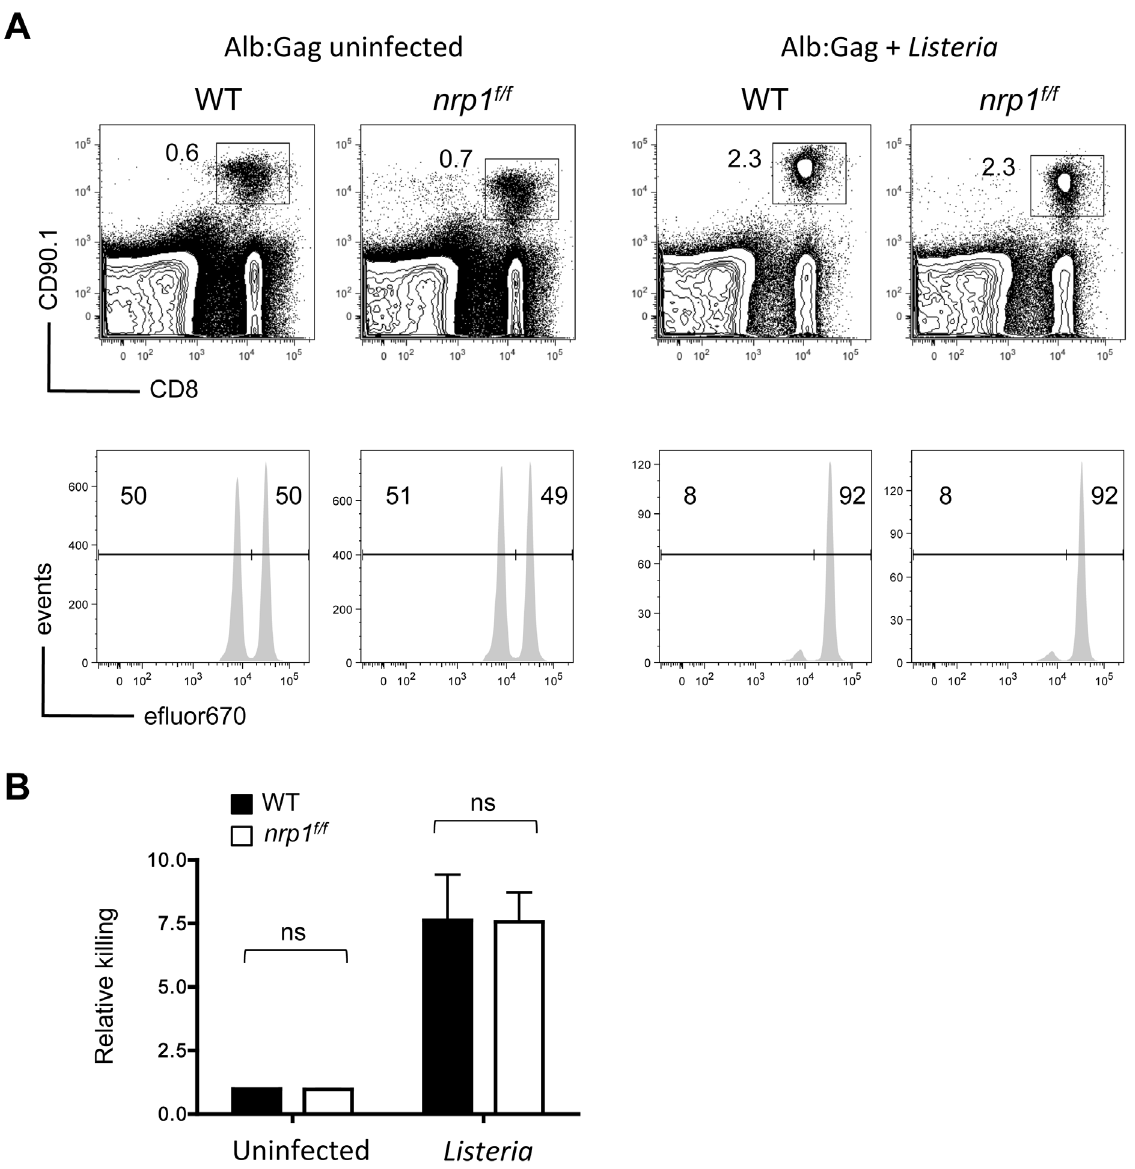
Figure 4. The cytotoxic potential of tolerant CD8 + T cells is not regulated by Nrp1. WT or Nrp1-deficient CD90.1 + Gag-specific CD8 + T cells were transferred into Alb:Gag recipients with or without Listeria infection. Three days after transfer, recipients were infused with a 1:1 ratio of Gag (eFluor 670 low ) and control (eFluor 670 high ) peptide-pulsed target cells. Twenty hours later (day 4), recipient spleens were harvested and the frequency of transferred Gag-specific T cells was determined by flow cytometry (upper panels). Inset numbers are the percent of total splenocytes within the inscribed regions. Target cell frequency is displayed as histograms with the percentage of total eFluor 670-positive cells inset above the indicated regions (lower panels). (B) Graph displays relative target cell killing (% eFluor 670 high /% eFluor 670 low ) pooled from 3 independent experiments. Error bars represent standard deviation (ns = not significant).